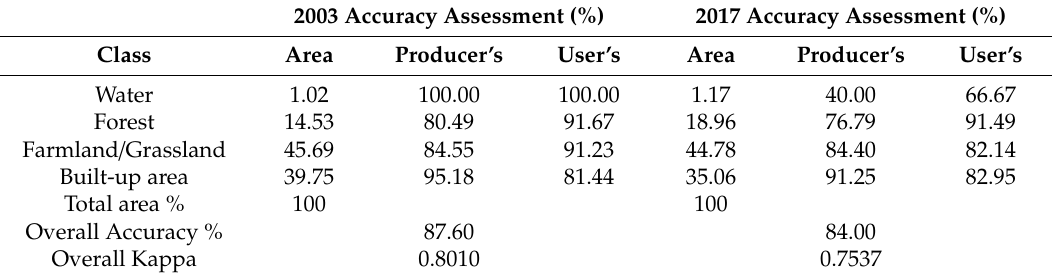
Table 4. Accuracy assessment results of LANDSAT images.